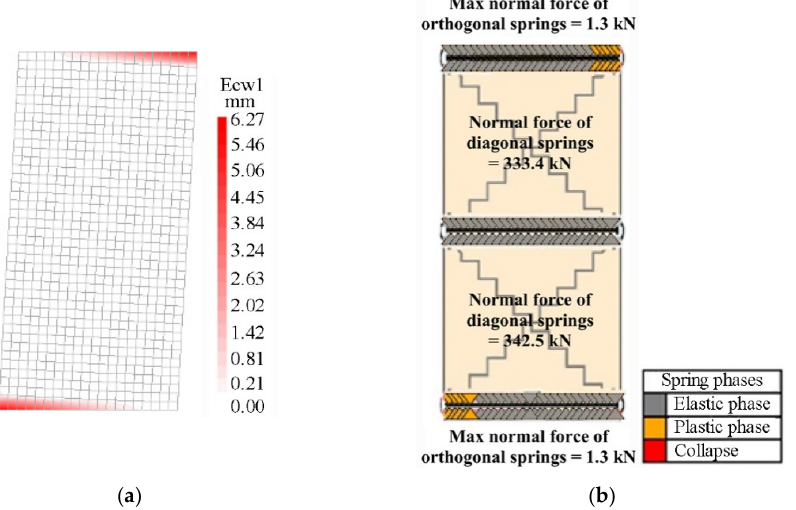
Figure 8. Comparison between the crack patterns in the slender masonry panel at the peak load step: ( a ) FEM, ( b ) DMEM.